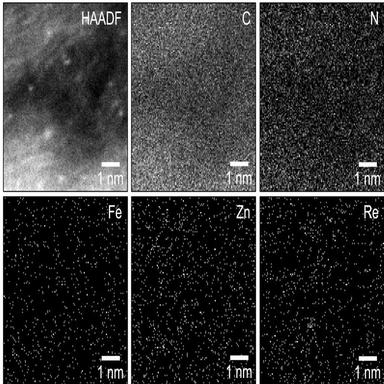
High-resolution STEM-EDS mapping of the FeReNC material. Even when acquired over five minutes on an aberration-corrected instrument with an EDS system that has high collection efficiency, the signal is not sufficient to generate a localization of counts on individual metal atoms (although a few additional counts can be observed where multiple Re atoms are clustered).